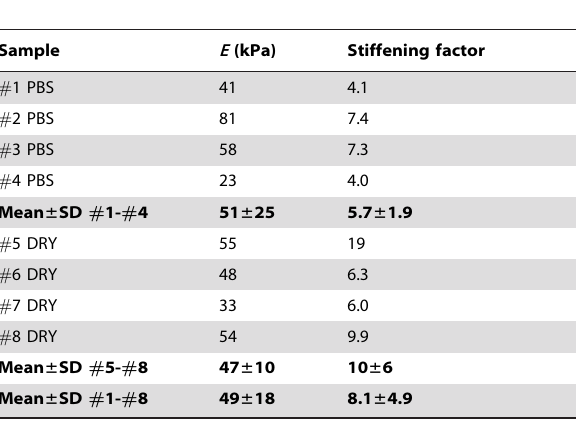
Table 4. Mean Young’s modulus E (kPa) and corresponding stiffening factor within stromal depth intervals of both groups (PBS and DRY) combined.